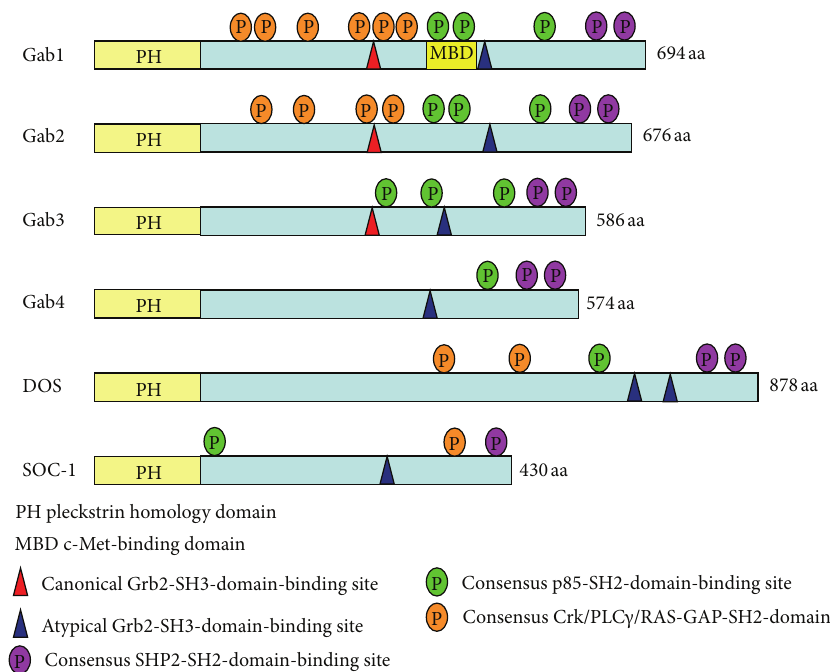
Figure 1: Schematic structures of Gab family docking proteins. Shown are the schematic domain structures of three human Gab proteins (Gab1–3), the putative human Gab4 protein, Drosophila DOS, and C. elegans SOC-1. All Gab proteins consist of a highly conserved N-terminal PH domain that is involved in membrane targeting. The central proline-rich regions mediate the association with SH3 domain-containing adaptor proteins such as Grb2. Consensus binding motifs favored by various SH2 domain-containing proteins such as SHP2, p85, Crk, and PLC 𝛾 are